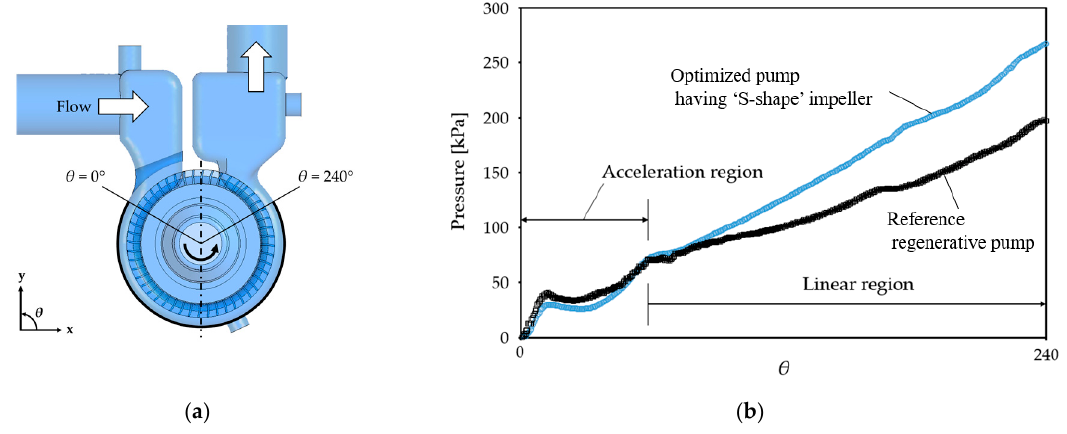
Figure 14. Pressure comparisons along the pump casing: ( a ) measuring position; ( b ) pressure.